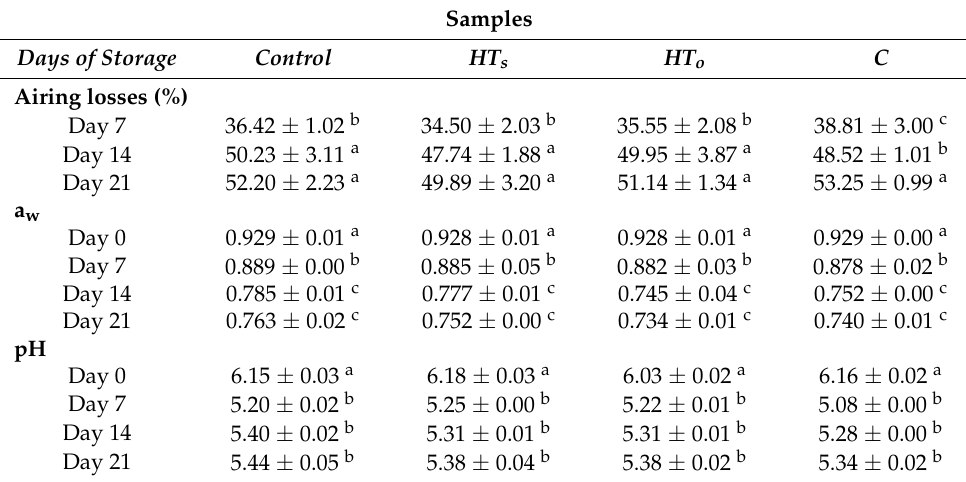
Table 3. Physicochemical quality evolution of fuet samples during ripening